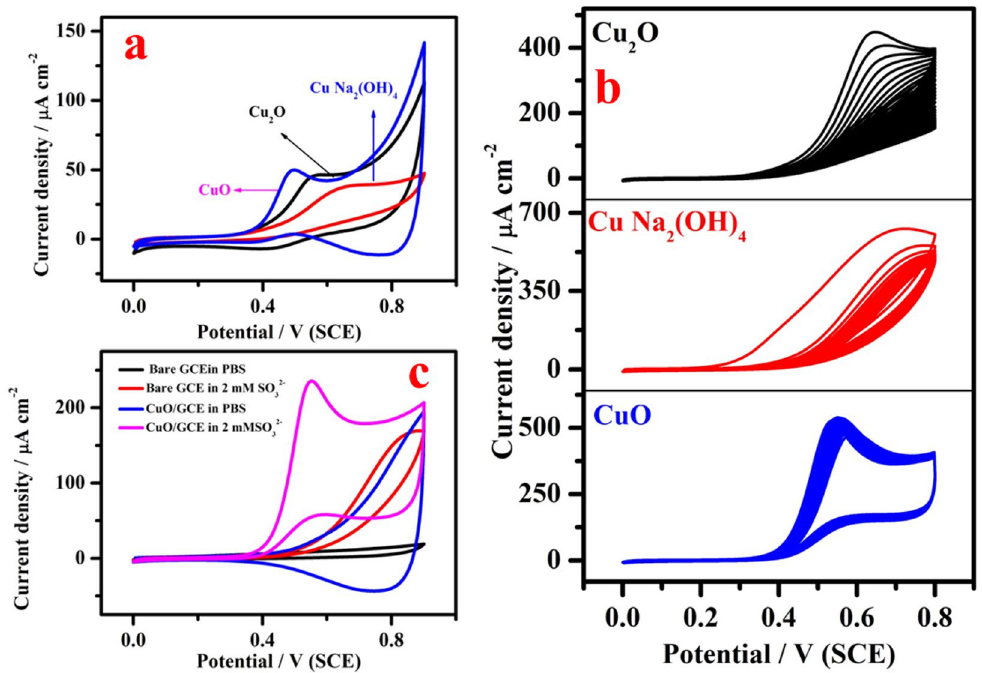
Figure 7. ( a ) CV of 2 mM of SO 3 2− in 0.1 M PBS (pH 7) on CuNa 2 (OH) 4 (blue colour), Cu 2 O (black colour) and CuO (blue colour) modified electrodes; ( b ) stability studies of Cu 2 O, CuNa 2 (OH) 4 and CuO modified electrodes using cyclic voltammetry in 5 mM of SO 3 2− and ( c ) CVs of bare GCE (black colour) and CuO modified GCE (blue colour) in pure 0.1 M PBS; bare GCE (red colour) and (pink colour) and CuO/GCE containing 2 mM of SO